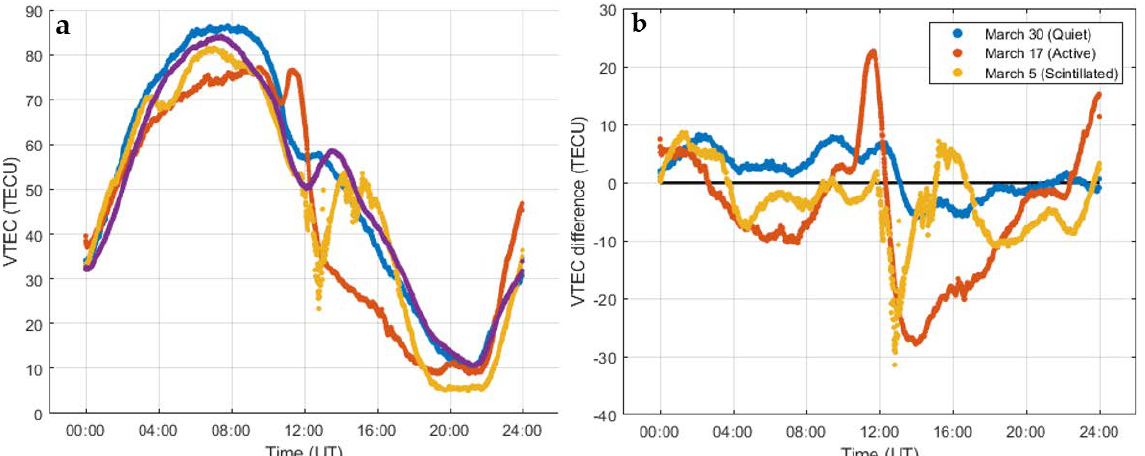
Figure 7. ( a ) 1 − dimensional VTEC timeseries of 30 March (quiet), 17 March (active), 5 March (scin- tillated) and the average quiet day VTEC of March 2015 observed by PIMO station and ( b ) difference between the average quiet day and the three dates. Positive values denote higher VTEC levels than average and vice versa. This shows the variation in VTEC during different geomagnetic and ionospheric conditions.